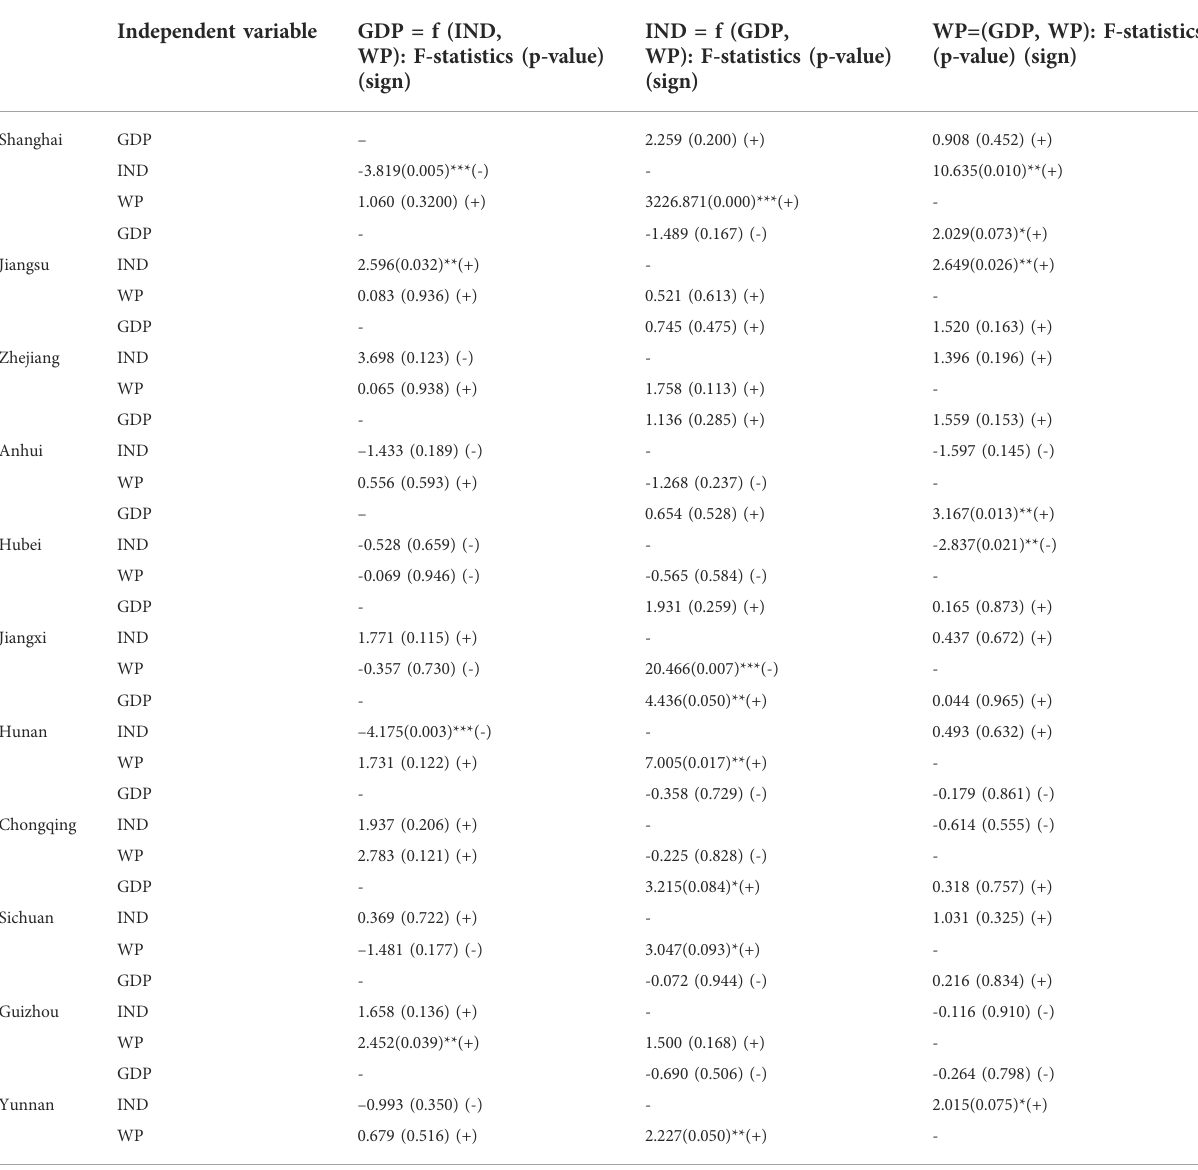
TABLE 4 Granger causality test